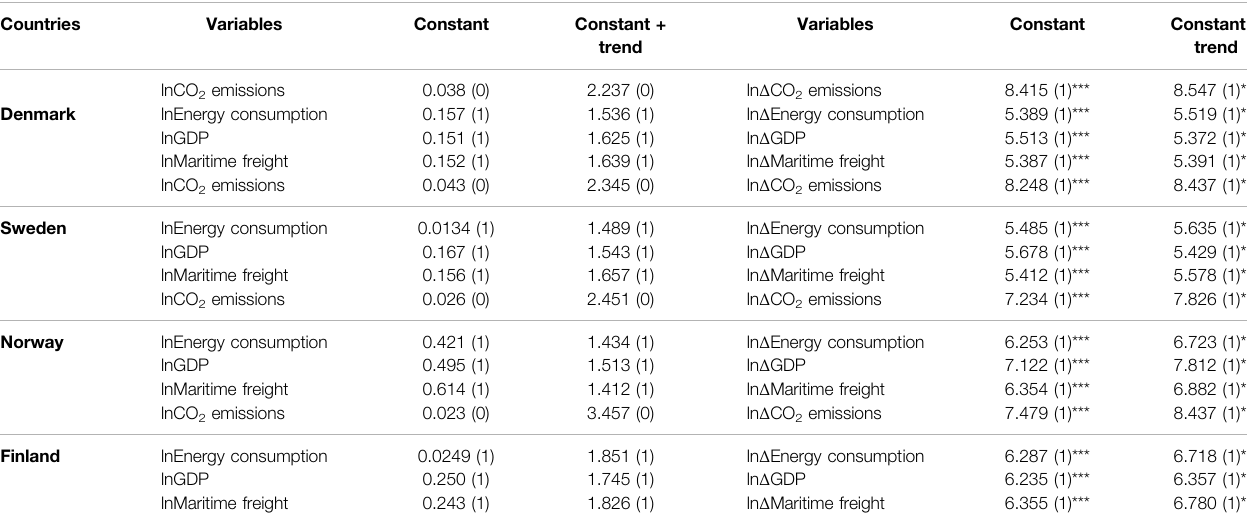
TABLE 4 | DF-GLS unit root test results for Scandinavian countries.